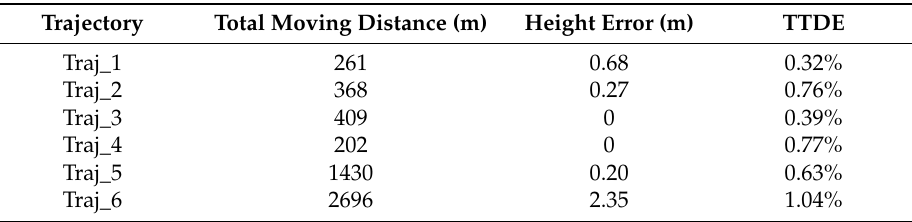
Table 8. Key indicators of the six experiments.